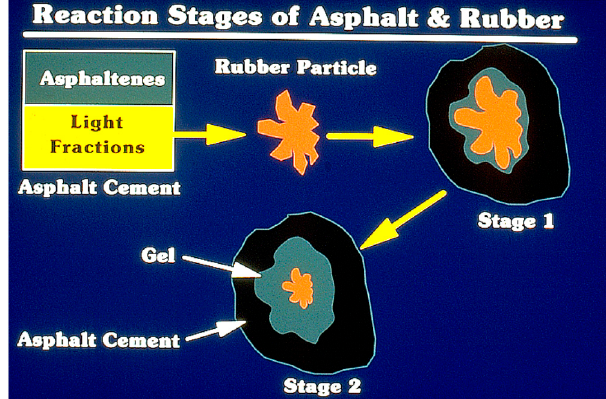
Figure 3. Swelling mechanism of rubber [23].